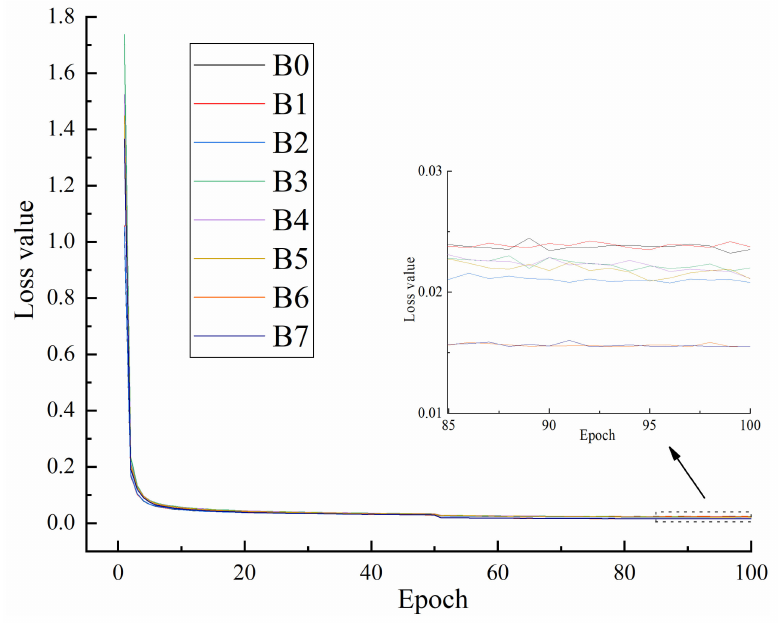
Figure 6. The loss value change chart of each